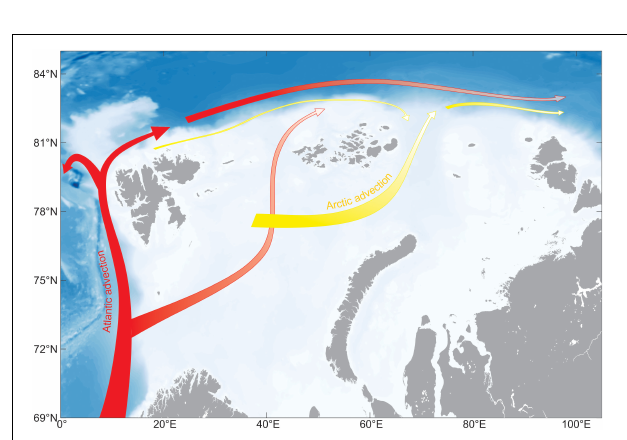
FIGURE 2 | The upper layer advective domain of the European sector of the Arctic Ocean. The Atlantic (red) and Arctic (yellow) advective domains are